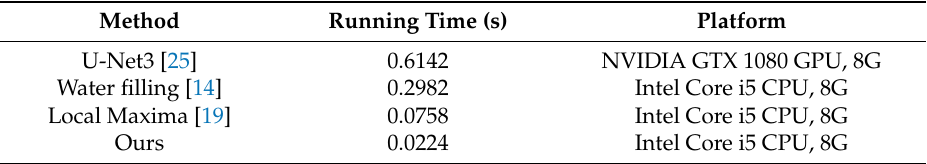
Table 6. Running time and hardware platform in various human detection methods.